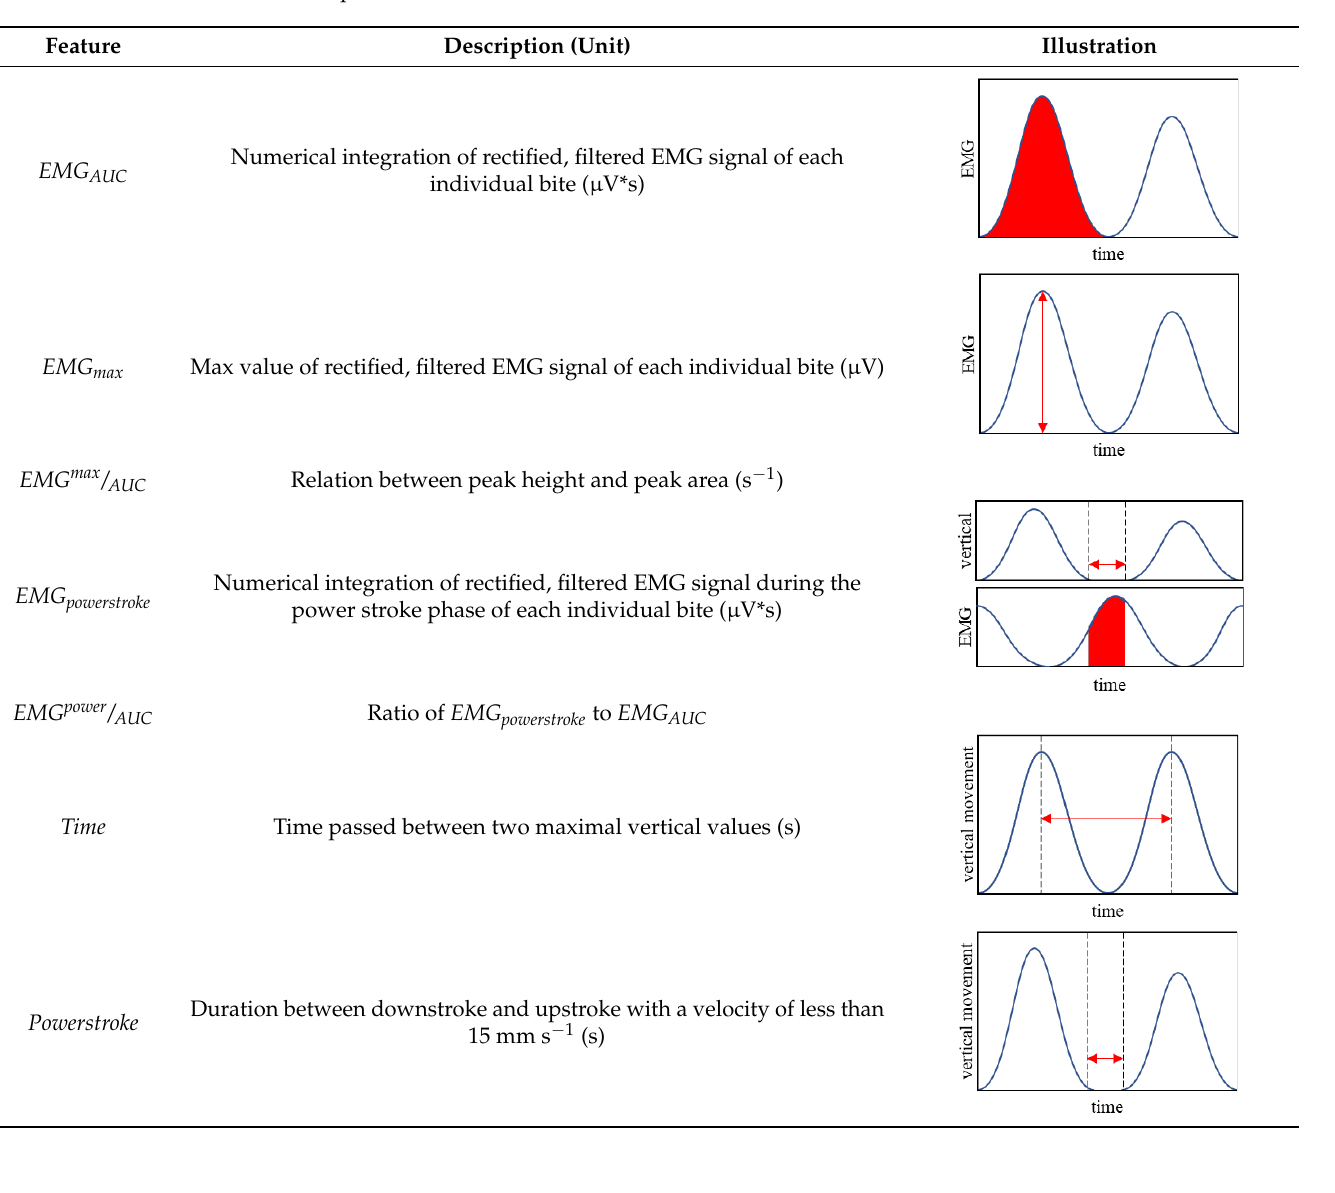
Table 1. Features calculated from 3D- and EMG-data with brief description of calculation and explanation of each feature.